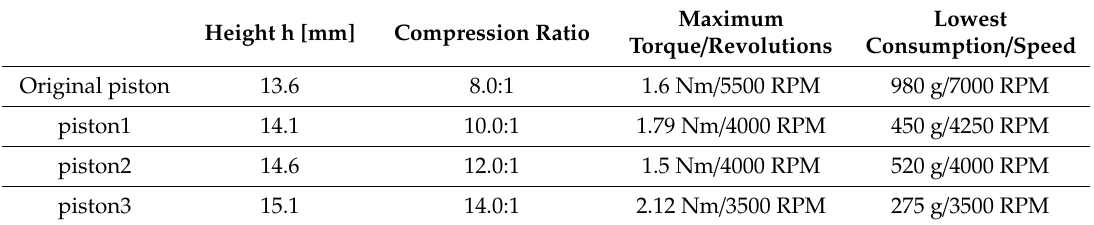
Figure 23. Engine torque characteristics for piston no. 3. Table 3. Comparison of engine characteristics using di ff erent